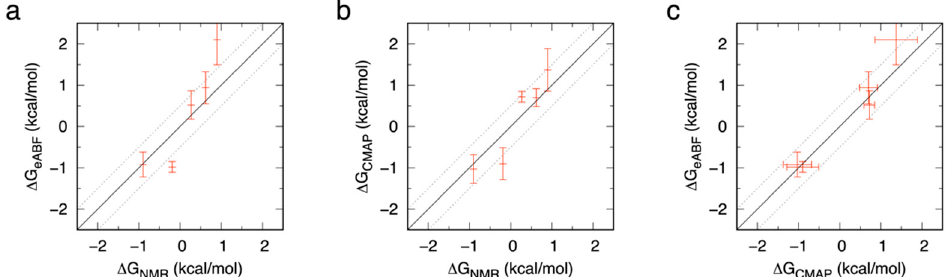
Figure 7. Comparison of ∆ G values for the 4 C 1 to 1 C 4 equilibrium in Ido and IdoA compounds from eABF simulations, CMAP-biased simulations, and NMR experiments. Data are presented as eABF vs. NMR ( a ), CMAP-biased vs. NMR ( b ), and eABF vs. CMAP-biased ( c ). The specific compounds